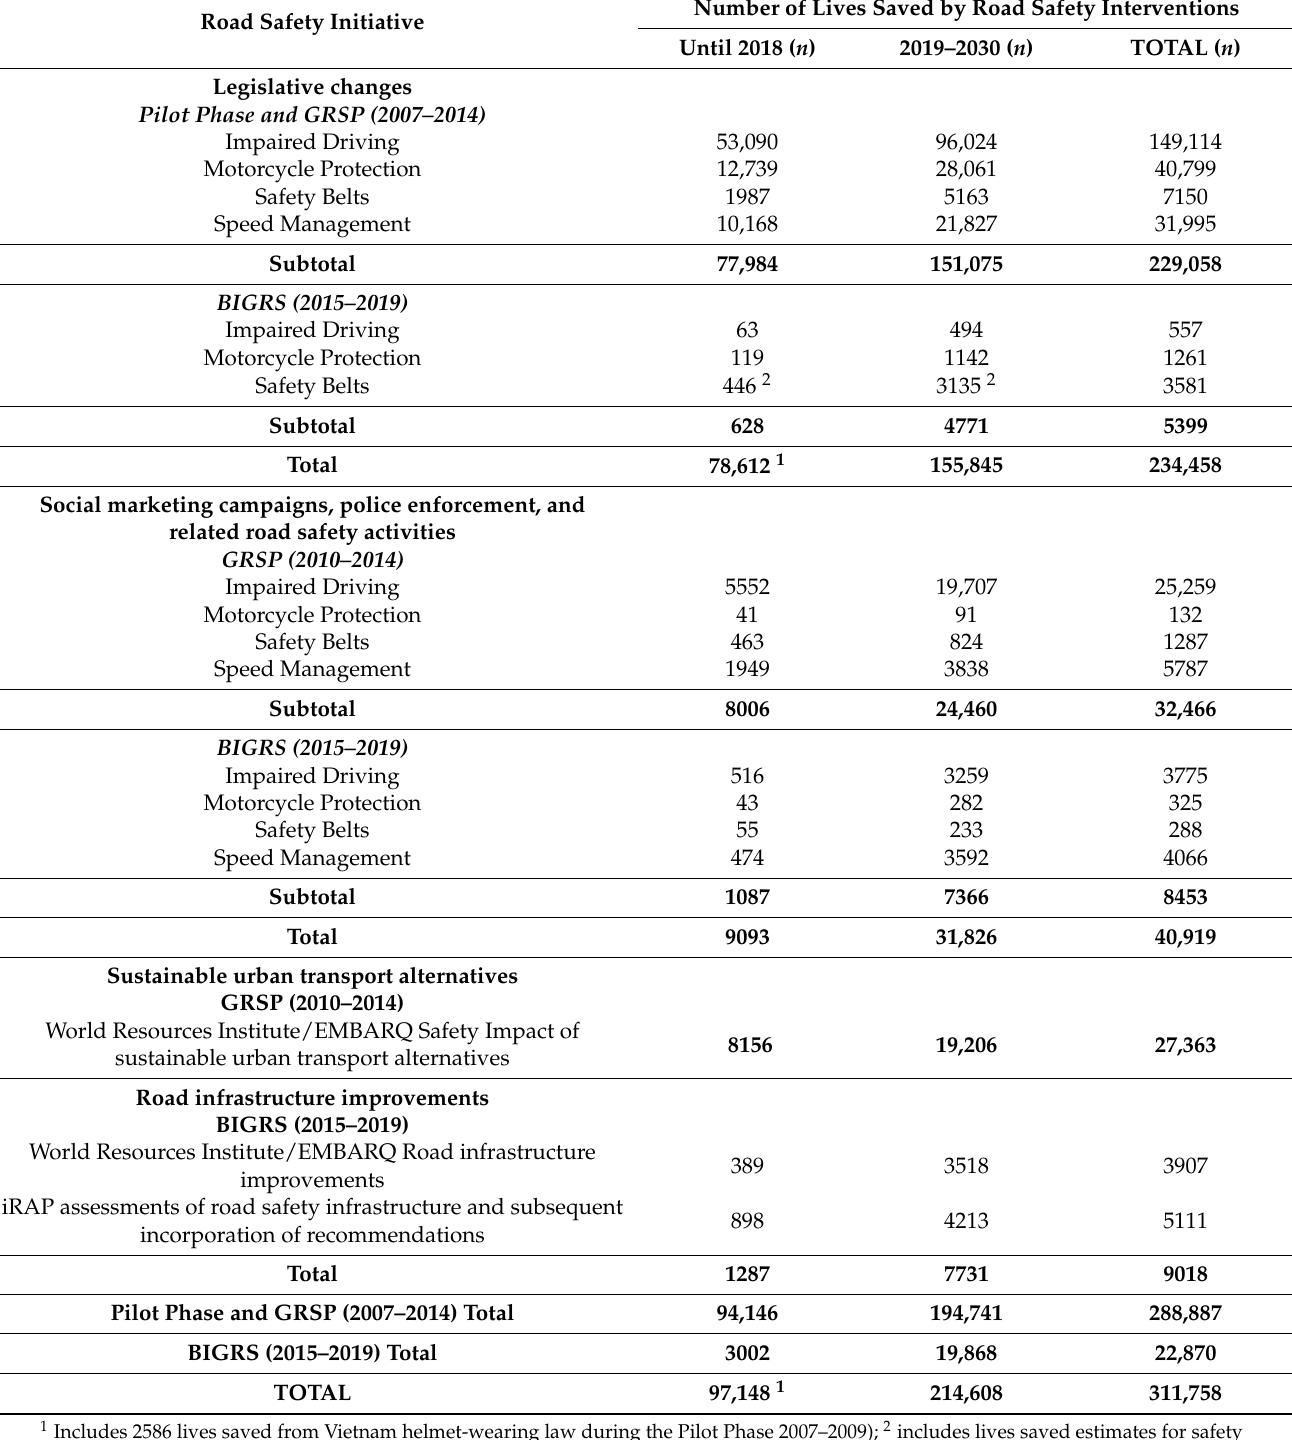
Table 1. Summary of lives saved by road safety initiatives undertaken by Bloomberg Philanthropies and partner organiza- tions,